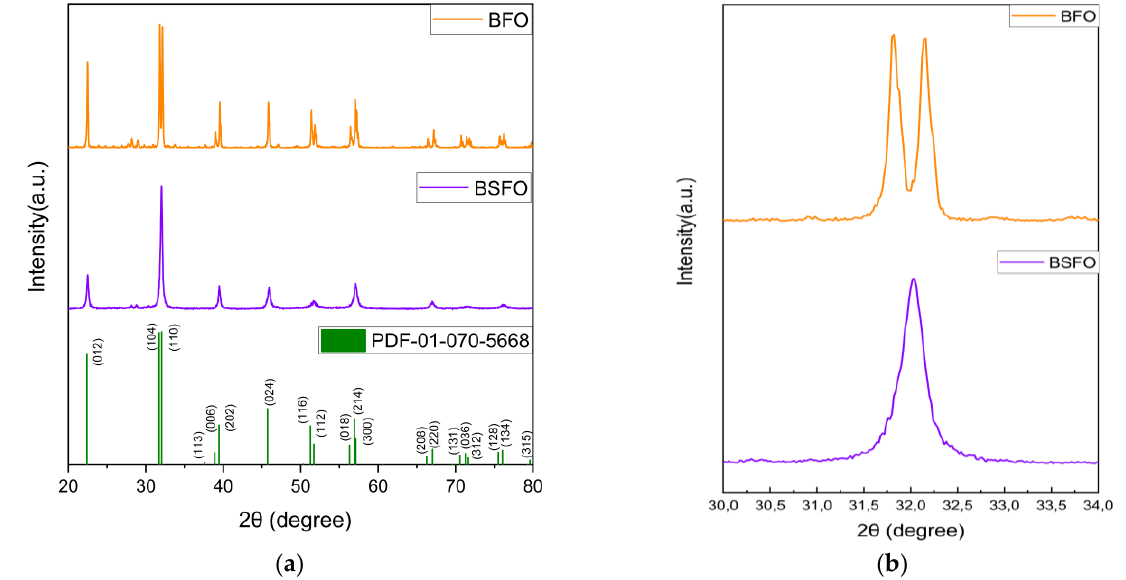
Figure 2. XRD patterns of ( a ) pure BFO and BSFO samples. ( b ) Peak merging of BSFO. Scanning electron microscopy was used to confirm the materials’ nanocrystalline structure of BFO and BSFO. The SEM electrograph in Figure 3a,b show there are micrometer-sized primary flakes that are agglomerated with irregularly shaped nanoparticles on top of them. Their particle size is between 30 and 100 nanometers in size. The doping has contributed to the overall size by reducing the size of the particles overall. Strontium oxide has a greater melting point (2531 °C) than bismuth oxide (817 °C), which may be inhibiting grain development and causing the grain size to decrease [38]. EDX was also measured, and the values are listed below in the Table 1 for BFO and BSFO. The complete dataset is shown in the supplementary (Figures S2 and S3). They are in close agreement with the values published before, showing successful doping [26].